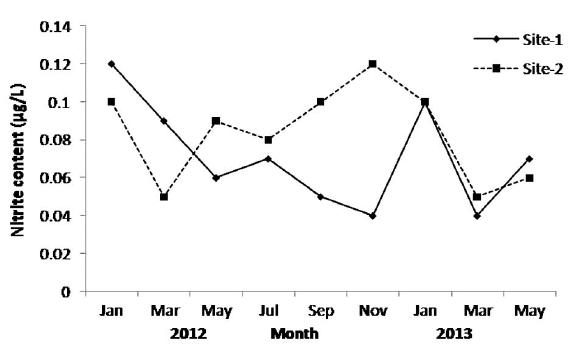
Fig. 9. – Seasonal variations in reactive silicate of seawater at Site 1, Payyannur (PNR), and Site 2, Panambur